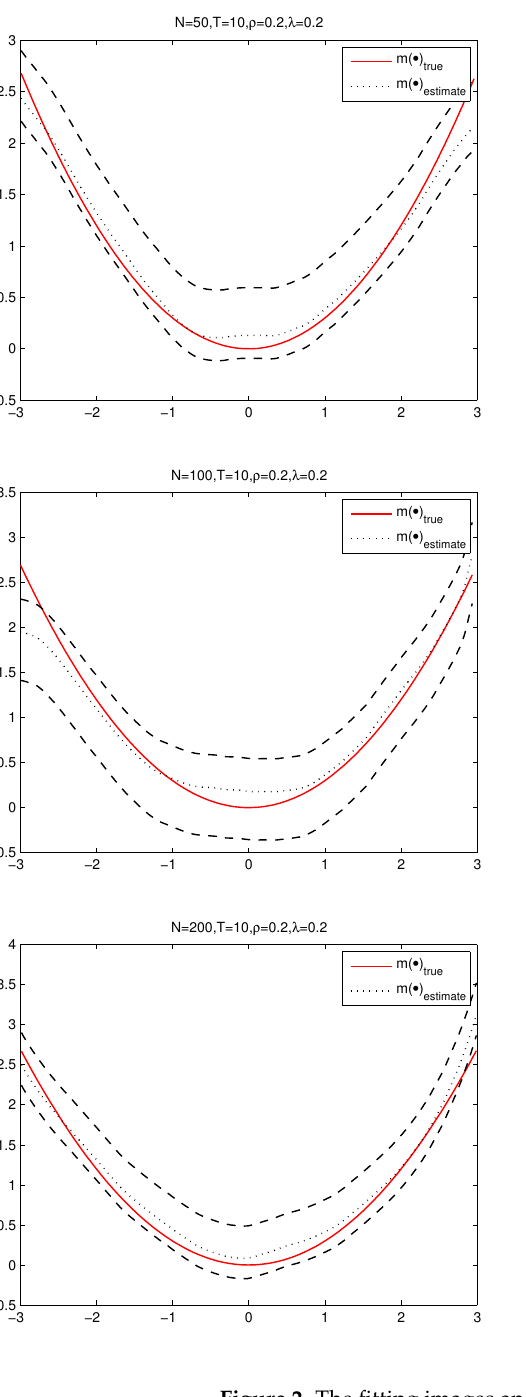
Figure 2. The fitting images and 95% confidence intervals of ˆ m ( z ) with ρ = 0.2 and λ =